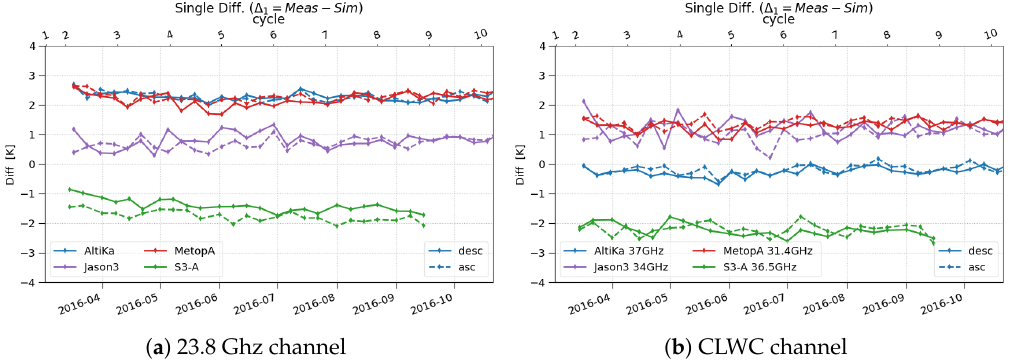
Figure 7. Single difference (MES-SIM) for ascending and descending passes for Altika, J3, Metop-A and S3A.